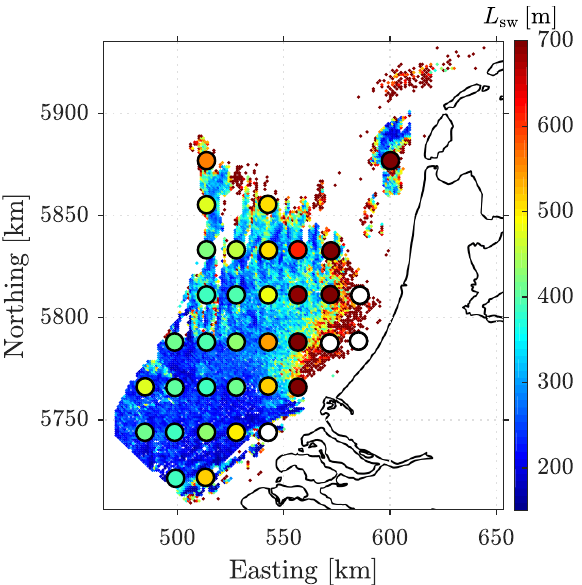
Figure 4. Uncalibrated modeled sand wave lengths L mod sw at calibration locations using S = 0.01m/s, T w = 6s, the same values as used in Campmans et al. [19], plotted on observed sand wave lengths L obs sw [12,33]. White markers indicate locations for which the model predicts no sand waves to